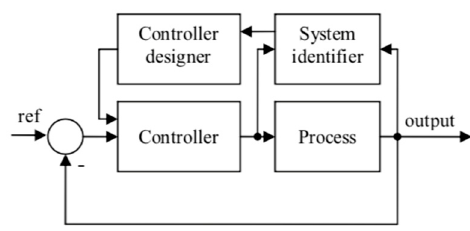
Figure 20. The self-tuning FO-PI controller.